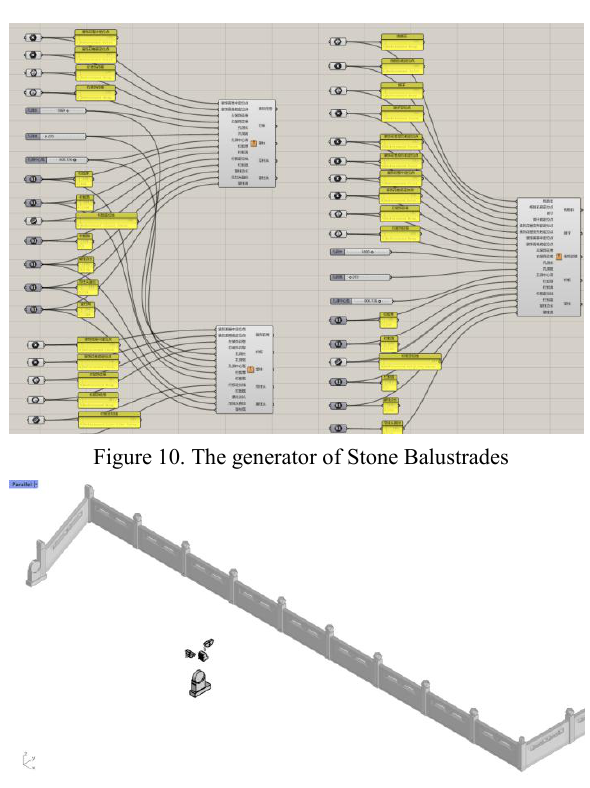
Figure 11. Generated Stone Balustrades